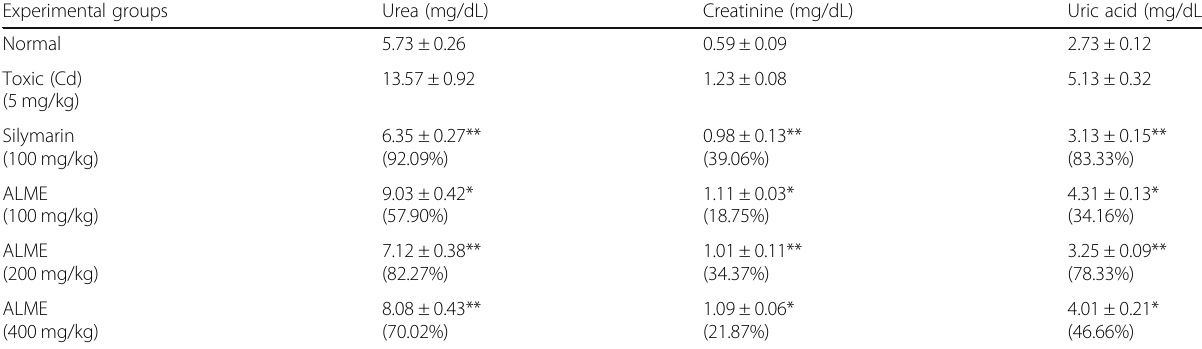
Table 2 Effect of ALME on cadmium induced changes in different serum kidney biochemical parameters Experimental groups